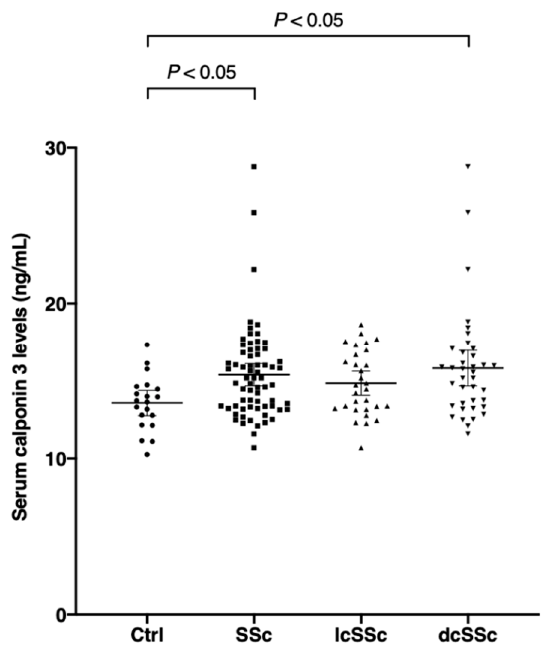
Figure 1. Serum calponin 3 levels in systemic sclerosis (SSc), diffuse cutaneous systemic sclerosis (dcSSc), limited cutaneous systemic sclerosis (lcSSc), and healthy controls (Ctrl). Serum calponin 3 levels were measured by a specific enzyme-linked immunosorbent assay. The horizontal line in each column shows the mean. The Kruskal–Wallis test was conducted for multiple-group compar- ison.